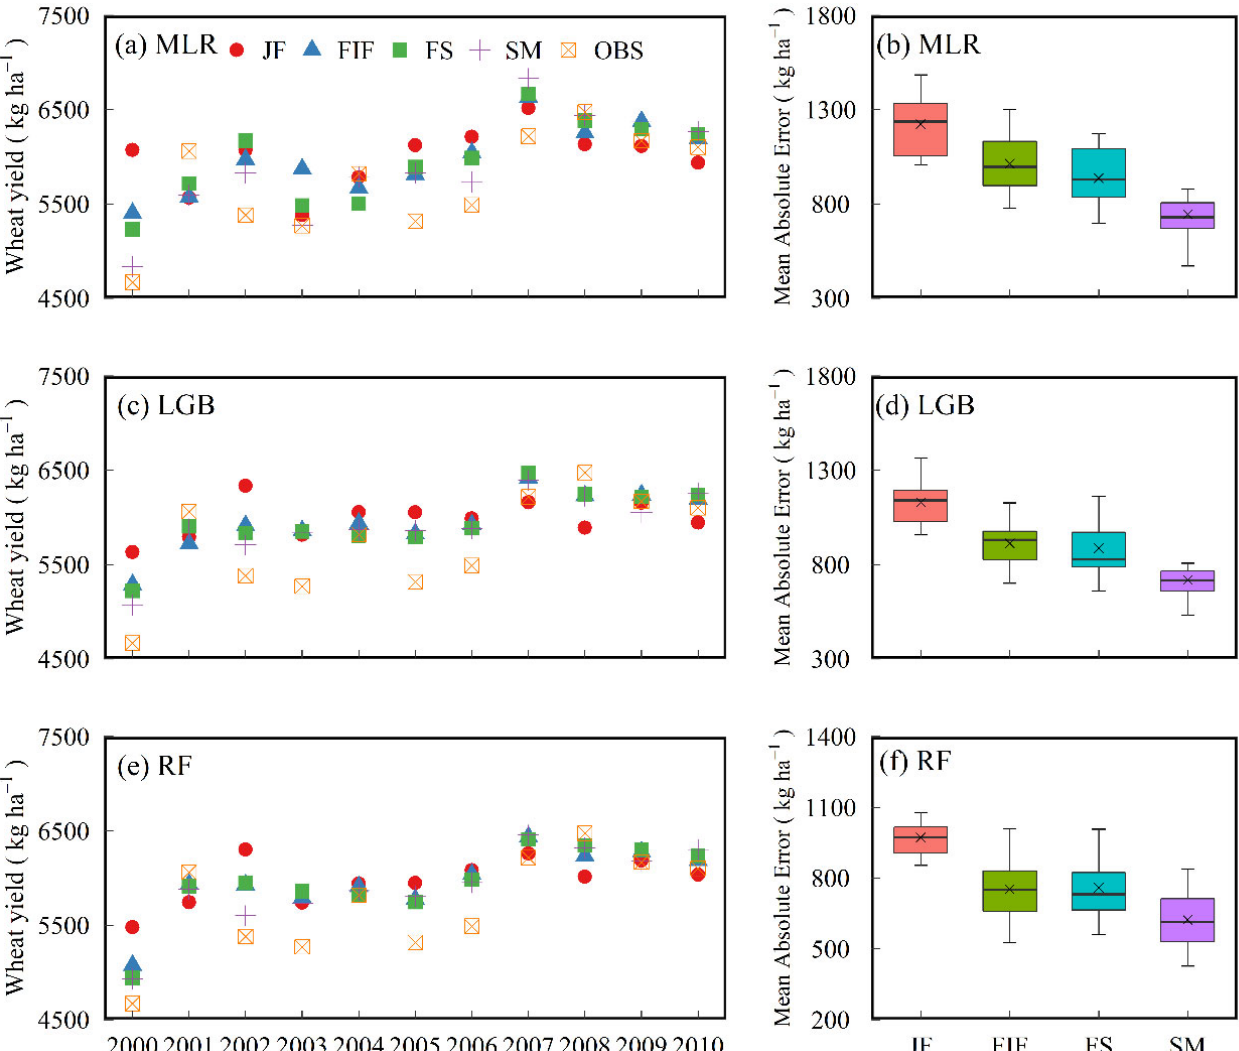
Figure 7. Time series of observed and predicted wheat yields across the investigated sites under rainfed conditions based on the four prediction events from multiple linear regression (MLR) ( a , b ), light gradient boosting machine (LGB) ( c , d ), and random forest (RF) ( e , f ). Wheat yields for each year were averaged across the investigated sites under rainfed conditions. Data were generated from the “leave-one-year-out” cross-validation procedure from the three regression models. JF, FIF, FS, and SM were the periods from the end of the juvenile stage to floral initiation, from floral initiation to flowering, from flowering to the start of grain filling, and from the start of grain filling to the milky stage, respectively.